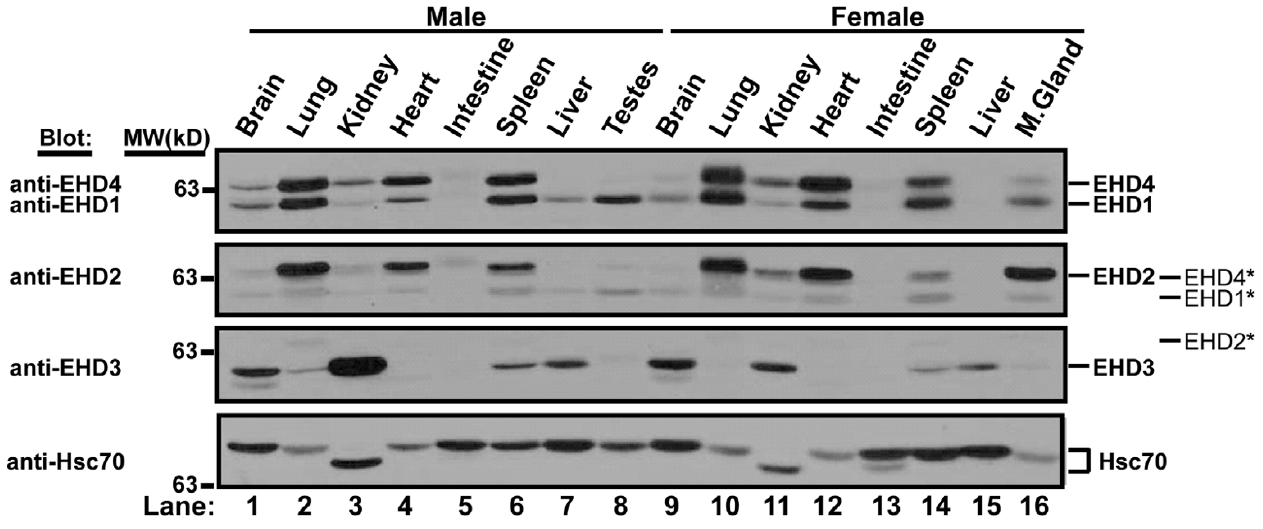
Figure 3 EHD protein expression in normal mouse tissues . An 18 week-old male and female C57BL/6 mouse was sacrificed, organs were removed and lysed in tissue lysis buffer as described in Methods. Aliquots of 100 µ g tissue lysate were separated using 8% SDS-PAGE and a Western blot was performed using antibodies raised against human EHD proteins. The membrane was serially stripped and reprobed beginning with both EHD1 and EHD4, followed by EHD2, EHD3 and Hsc70 antibodies. The * denotes bands that bled through from the previous blot following stripping. Differential mobility of Hsc70 may represent tis- sue specific isoforms. Blots shown have exposure times of less than 10 seconds, upon longer exposures, most EHD proteins can be seen in each organ shown. Relative molecular weight (MW) markers are indicated in kiloDaltons (kD). As a loading con- trol, Hsc70 was blotted. M. gland – mammary